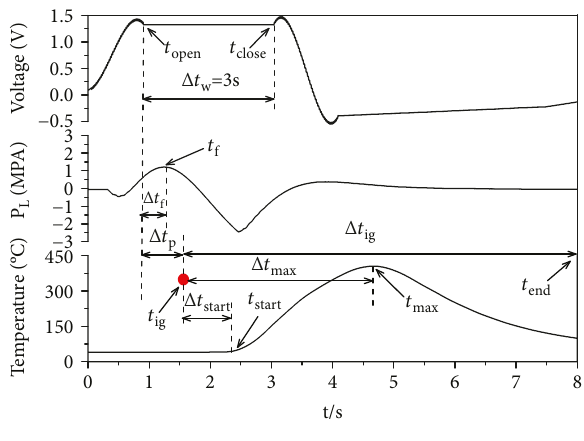
Figure 3: De fi nition of ignition